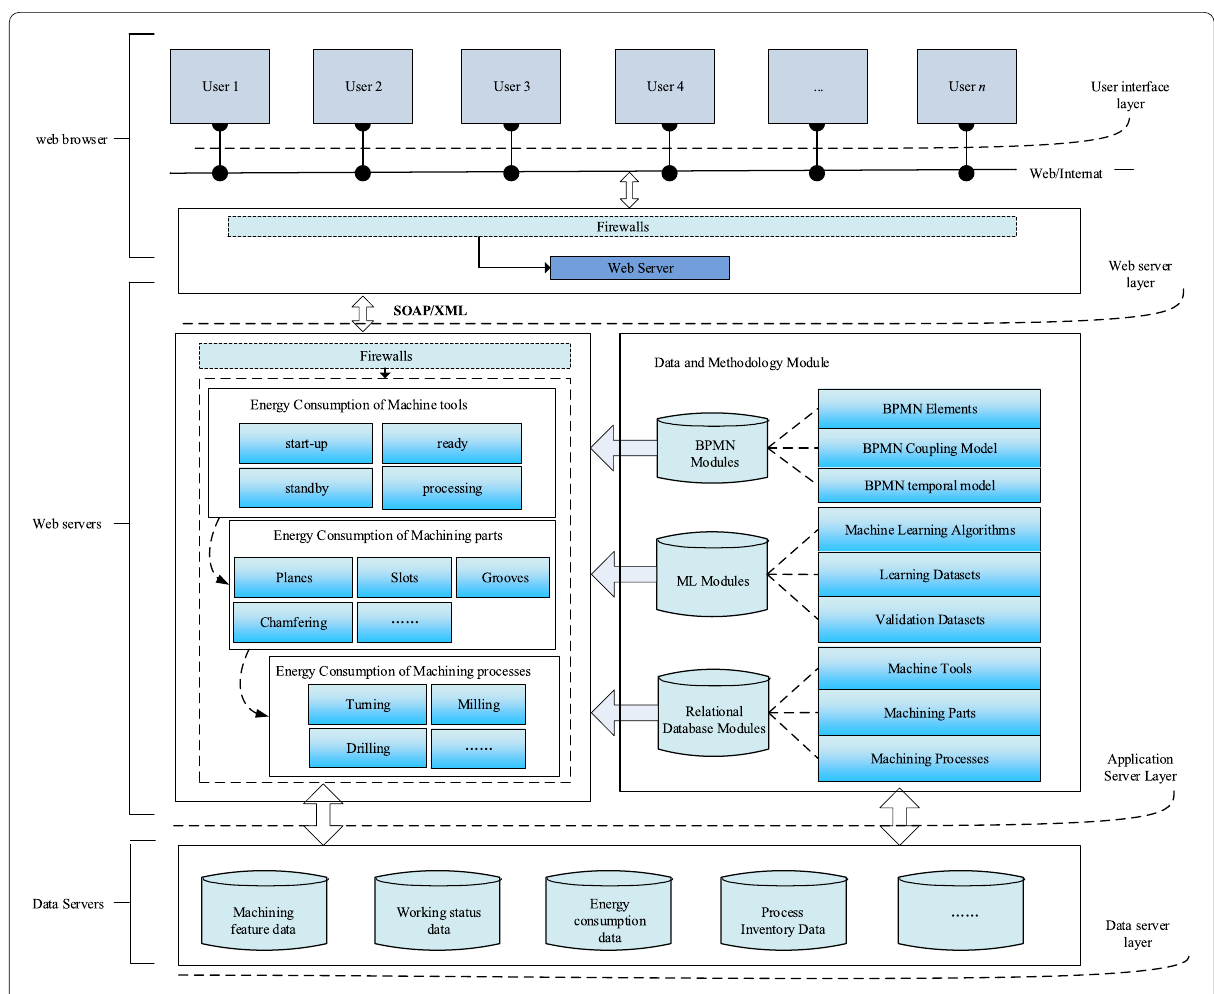
Figure 1 The architecture of the service-oriented energy assessment